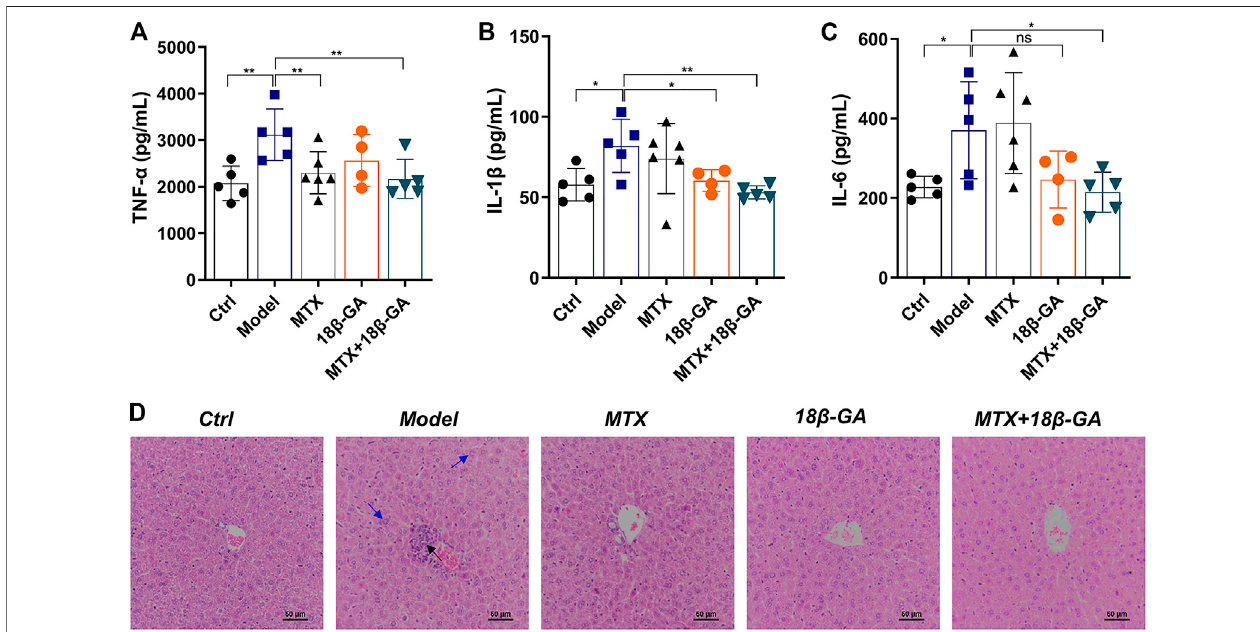
FIGURE 5 | 18 β -GA attenuates secretion of serum cytokines and liver pathological injury. (A – C) Serum levels of TNF- α , IL-1 β , and IL-6 were measured by ELISA. Dataareshown asmean ± SD.* p < 0.05; ** p < 0.01; *** p < 0.001, n (cid:2) 4 – 6. (D) Representativeimagesofpathologyand sectionsoftheliverinmiceindifferentgroupsare shown in D. Black arrow indicates portal in fl ammation, and blue arrow indicates hepatocyte swelling and loosening.